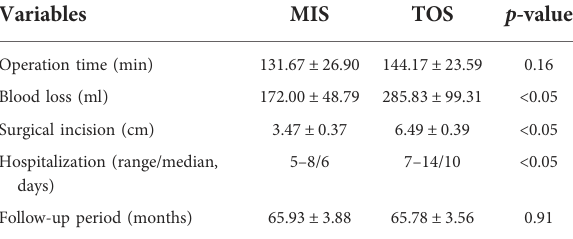
TABLE 3 Comparison of variables between two groups.